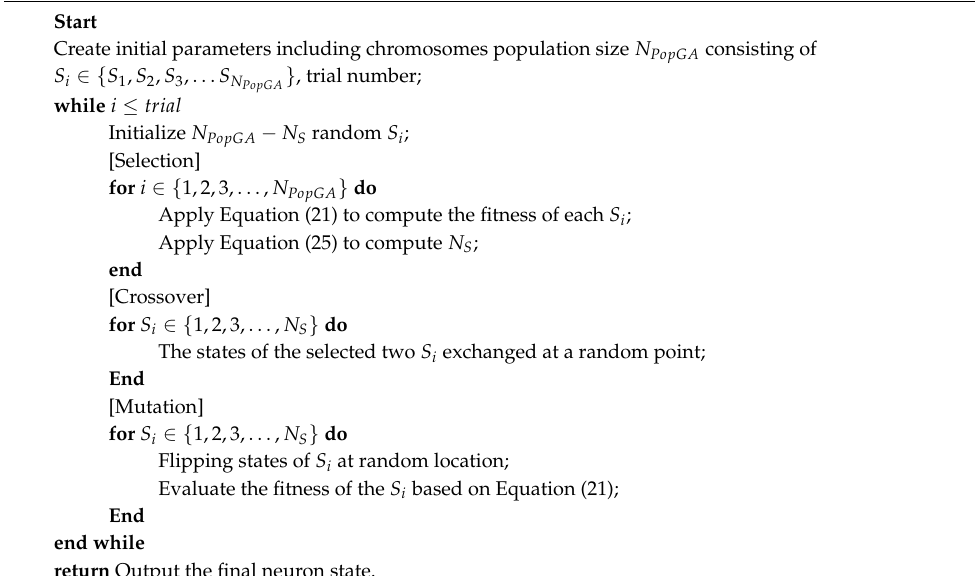
Algorithm 2: The pseudocode of GA in the training